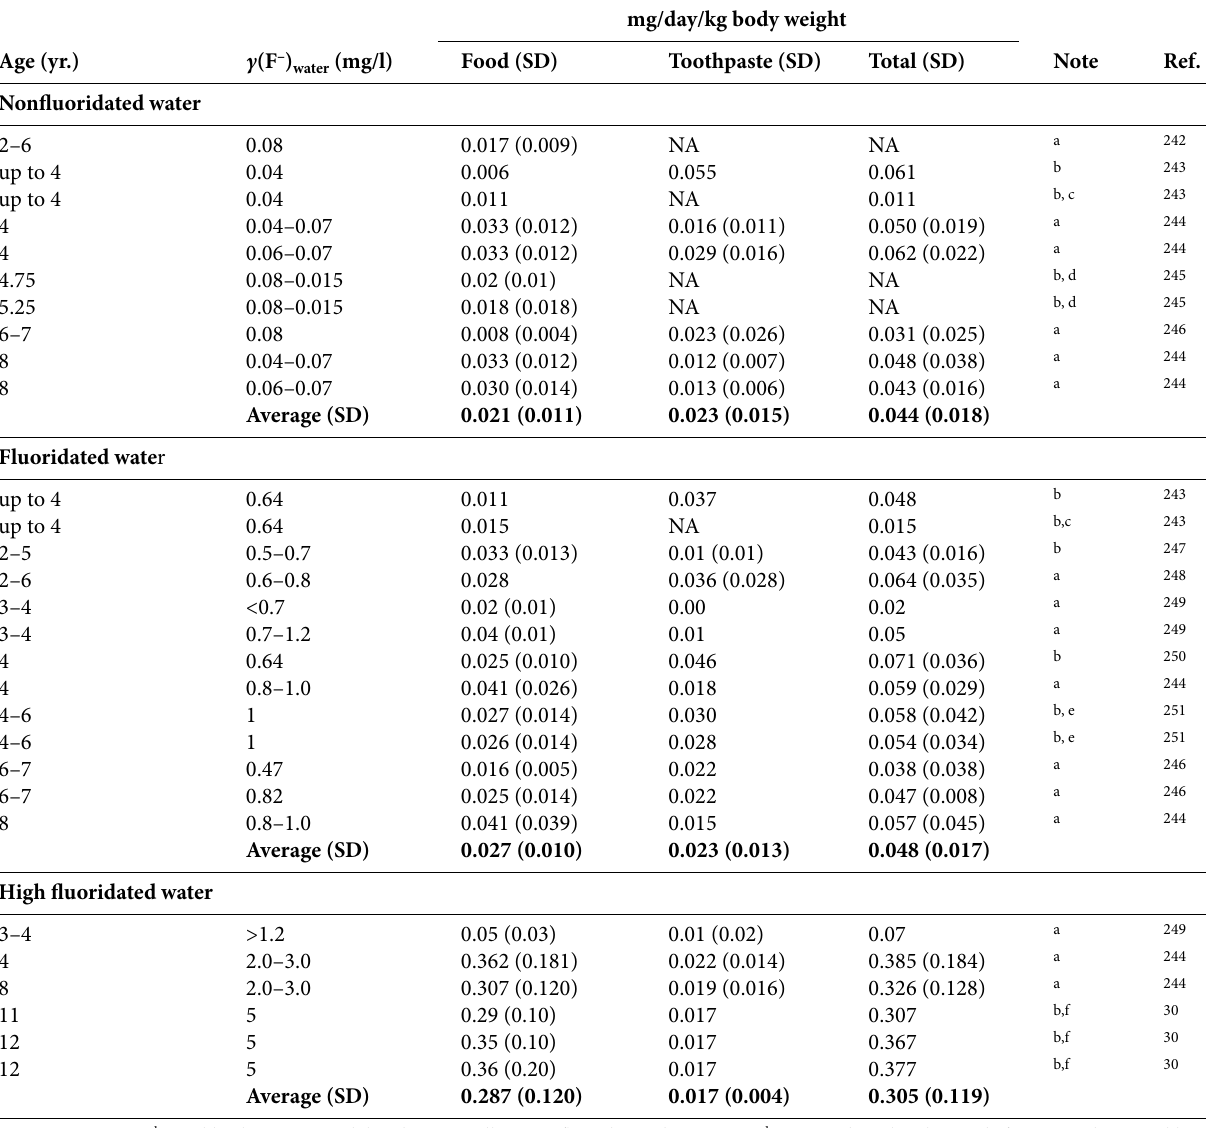
mg/day/kg body weight